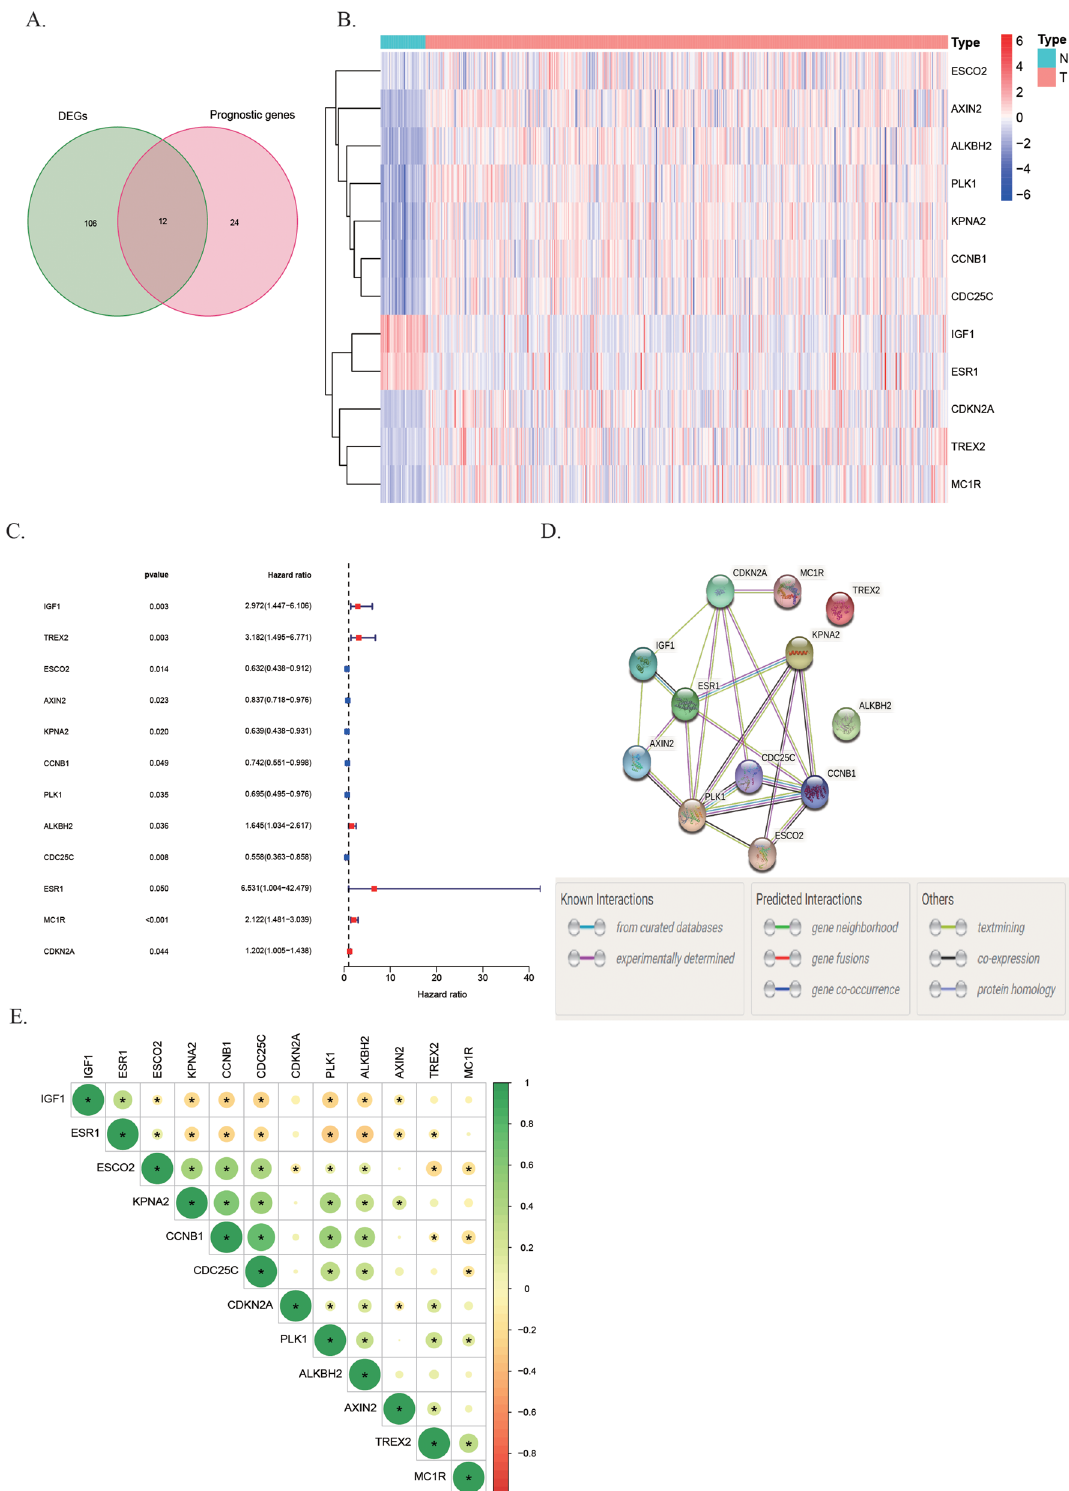
Figure 2. Identification of prognostic DNA repair-related DEGs in TCGA. (A) Venn plot to identify prognostic DE-DRGs in CRC based on data from TCGA; (B) the expression patterns of the 12 DE-DRGs in a heatmap; (C) forest plots of 12 DE-DRGs associated with OS by univariate Cox regression. (D) The 12 DE-DRGs interactions of PPI network downloaded from STRING database. (E) The correlation heatmap of 12 DE-DRGs. The different colors presented correlation